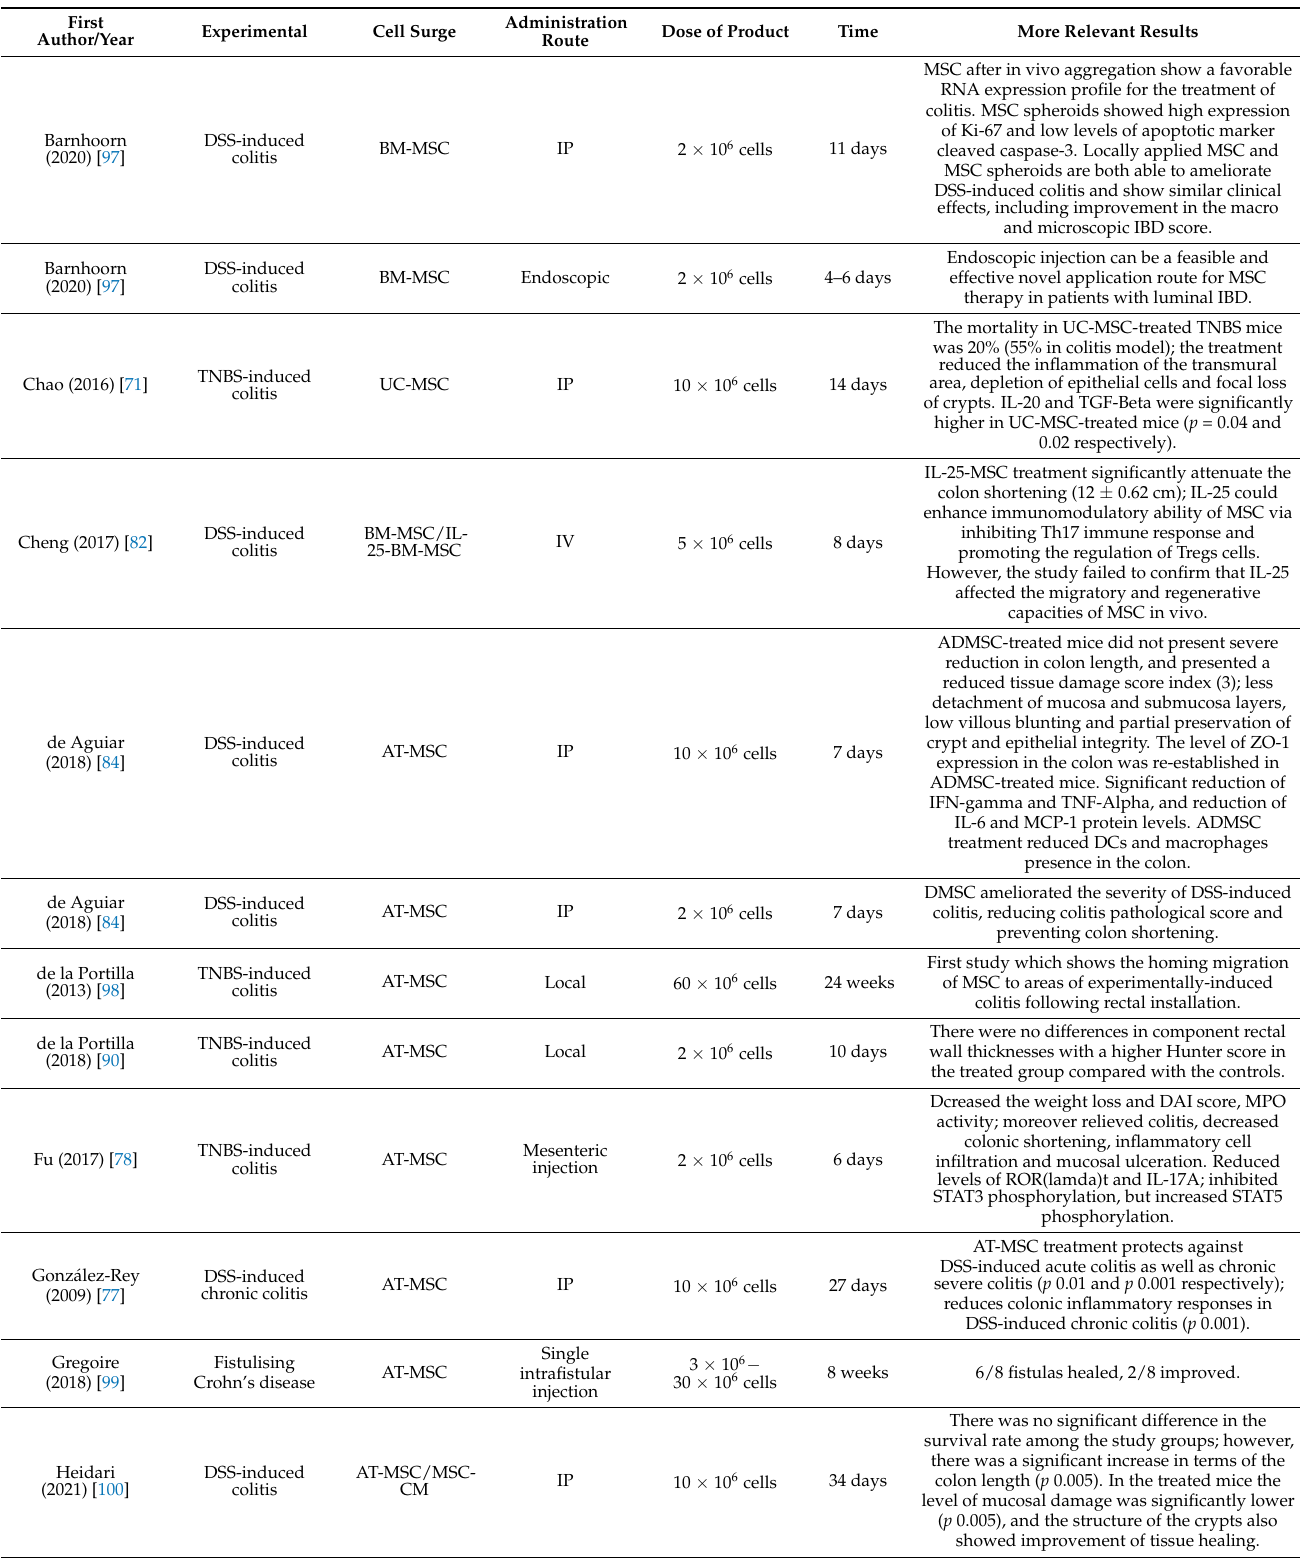
Table 1. Experimental in vivo studies based on MSC-therapy in